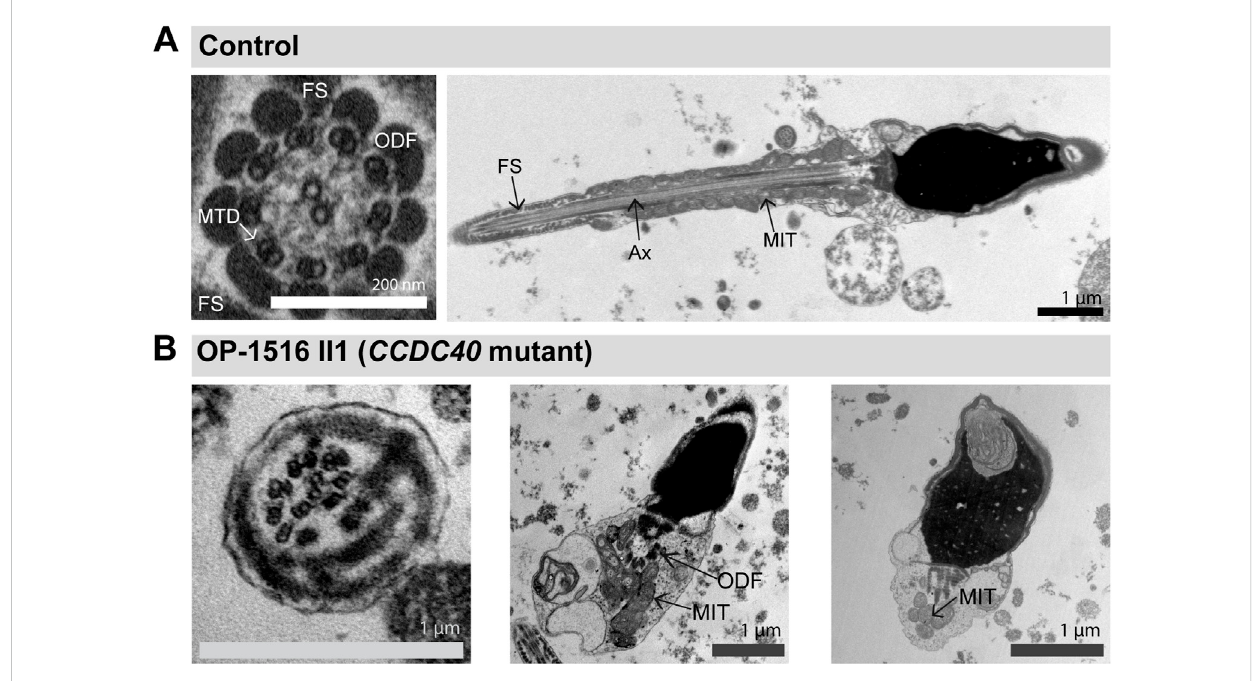
FIGURE 3 TEM analyses of CCDC40 -mutant sperm cells show morphological abnormalities and tubular disorganisation. (A) TEM micrographs of sperm samples from a healthy control donor, showing a fl agellar cross section with a regular 9 + 2 axoneme of microtubule doublets (MTD), (left image), and a longitduinal section showing the axoneme (Ax) at the center, with regularly composed mitochondria (MIT) and fi brous sheath (FS), respectively in the fl agellar mid piece and principal piece (right image). (B) CCDC40- mutant individual OP-1516 II1 shows morphological abnormalities of the sperm cells. Some sperm cells depict severe head malformations and lack proper fl agella, displaying a cytoplasmic bag with unassembled peri-axonemal components, such as outer dense fi bers (ODF) and mitochondria (right and middle image). In sperm fl agella cross sections, axonemes show severe tubular disorganization (left